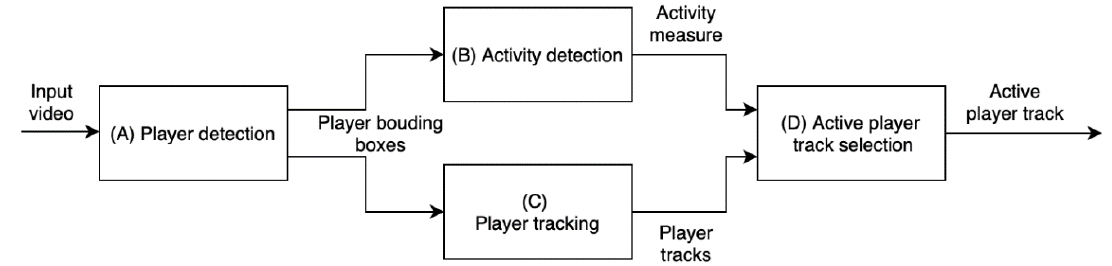
Figure 2. An overview of the active player track detection. Player detector provides bounding boxes for each input video frame ( A ). Player activity measure is computed for each detected player bounding box in each frame ( B ) and players are tracked across frames ( C ). Combining the track information from (C) and activity measure from (B), final decision about the active player track is made ( D ).